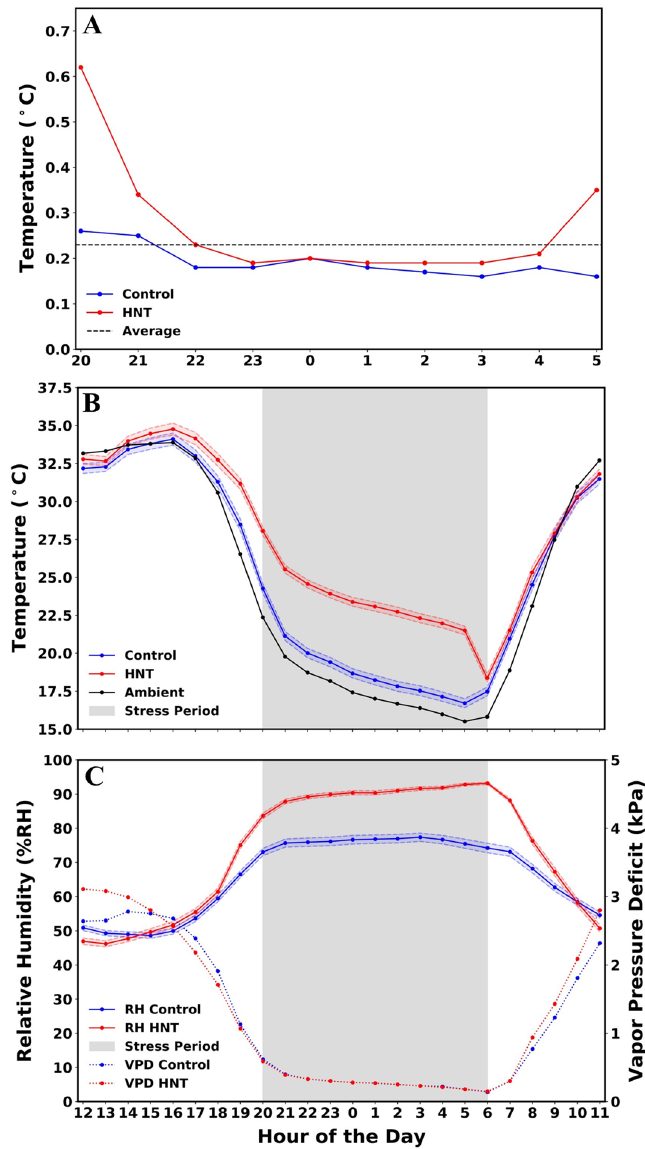
Figure 3. Environmental conditions in control and stress tents. ( A ). Comparison of the temperature differences between the HOBO data loggers within the same tents for control, HNT and overall average. The lower the temperature on the graph represents a more uniform heat distribution as the sensors were spread randomly throughout each tent, see Fig. 2. ( B ). A comparison of the average temperature within the stress tents, control tents and ambient conditions starting at 12:00 PM and ending at 12:00 AM over the entire duration of the experiment. ( C ). The control and stress tents average relative humidity and vapor pressure deficit are shown throughout the day. 95% confident intervals are represented by the shaded regions above and below the control and stress lines for temperature ( B ) and relative humidity ( C